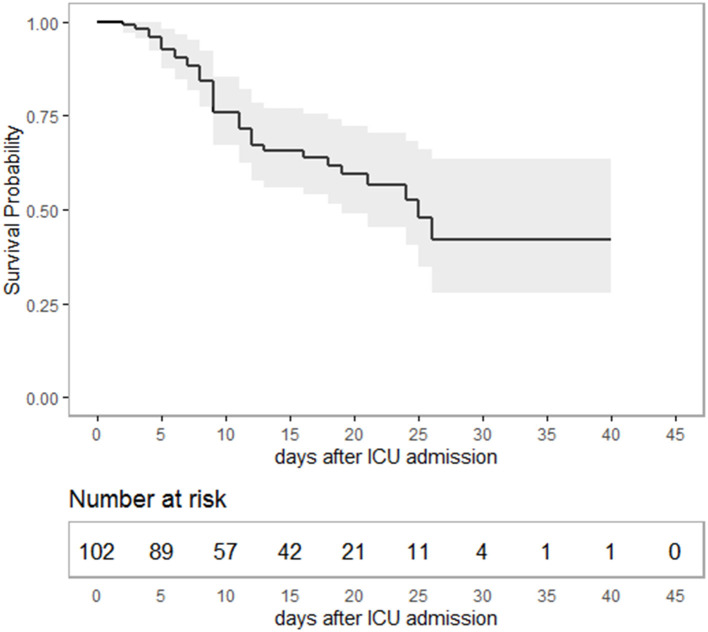
Kaplan-Meier-plot showing survival probability as a function of time in intensive care. Overall, 65% (95%-CI 55.6–73.5) of the patients survived ICU treatment with a median duration of 11 (IQR: 7–19) days. The study period ended with ICU discharge or death, respectively. Hence, survival data are terminally censored resulting in a horizontal line on the far right.